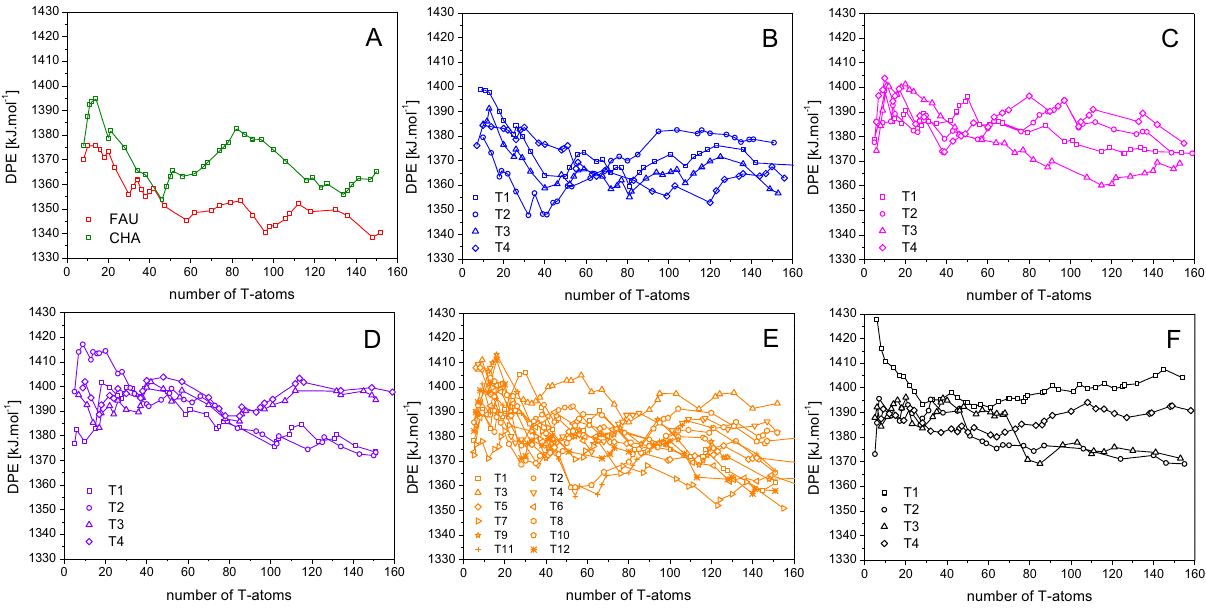
Figure 4. The vertical deprotonation energy dependence on cluster size for each investigated zeolite; ( A ) FAU and CHA zeolite, ( B ) IFR , ( C ) MOR , ( D ) FER , ( E ) MFI , ( F ) TON